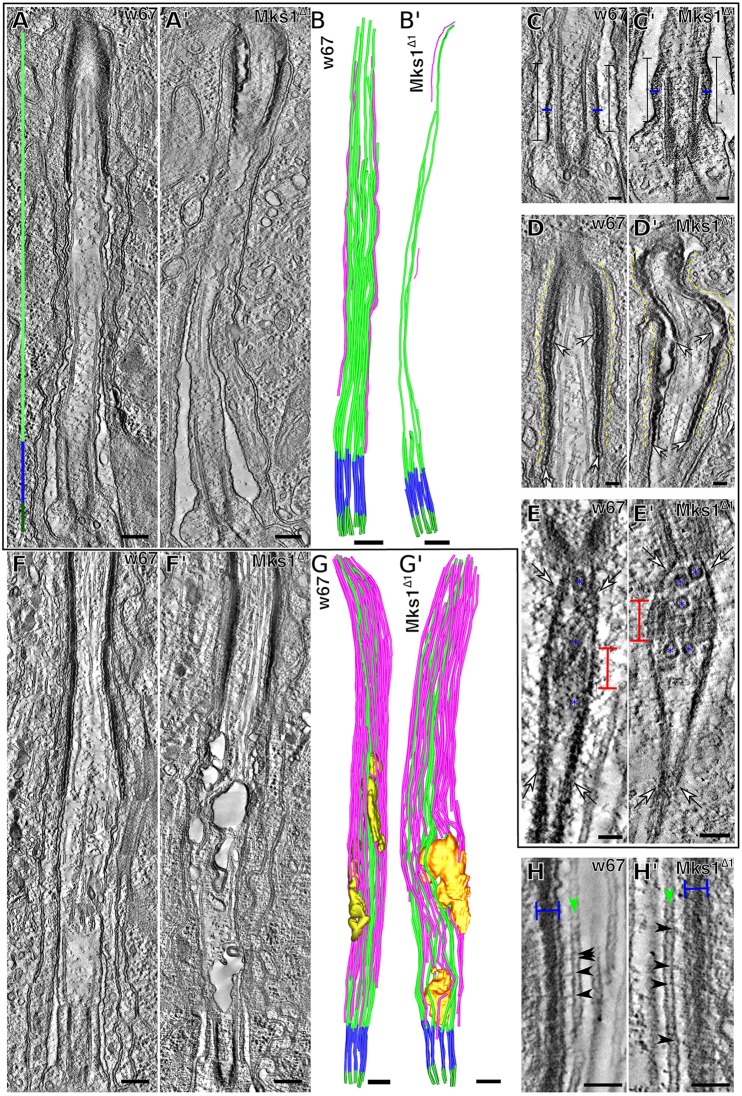
Mks1Δ1 mutant sensory cilia exhibit structural defects at 48 h APF, but are relatively normal by 72 h APF. (A,A′) Micrographs show electron tomograms of the sensory cilium at 48 h APF in WT (A) and Mks1Δ1 mutants (A′). (B,B′) Illustrations show the corresponding 3D models of A,A′, highlighting the BB MTs (dark green), the TZ MTs (blue) and axonemal MTs (light green). Axoneme MTs not directly attached to the BB are highlighted in magenta. (C,C′) Higher magnification electron tomograms of the TZ (square capped lines) in WT (C) and Mks1Δ1 mutants (C′); the TZ is shorter in the mutant, and the electron-dense TZ membrane (blue lines) seems wider and more diffuse. (D,D′) At the tip of the WT axoneme there is a crystalline-like electron-dense structure (D, arrows) located between the ciliary membrane (adjacent to upper arrows) and the sheath cell membrane (highlighted by dotted yellow lines); this structure is present in the Mks1Δ1 mutant cilia (D′) (lower arrows) but the region is less-well organised, and there are gaps between the ciliary and sheath cell membranes (upper arrows). (E,E′) Electron tomograms of the area just below the ciliary BB in WT (E) and Mks1Δ1 mutants (E′) reveal the rootletin filaments (arrows) that originated from the BB, surround the daughter centriole (red capped lines) and extend into the neuronal cell body. Several vesicles (blue asterisks) are visible at the base of the BB and the daughter centriole in the space delimited by the rootlet. Analysis of this area revealed no obvious differences between WT and Mks1Δ1 mutants. (F–G′) Electron tomograms (F,F′) and the corresponding 3D models (G,G′) of WT (F,G) and Mks1Δ1 (F′,G′) sensory cilia at 72 h APF. The number of axonemal MTs increased from 48 h to 72 h, and mutant cilia appear more similar to WT, although an internal membranous structure can be discerned (gold) that is more extensive in Mks1Δ1 mutant cilia. (H,H′) At 72 h APF, electron-dense bridges (black arrowheads) connecting the MTs (green arrowheads) and the ciliary inner membrane are visible in both WT (H) and Mks1∆1 mutants (H′) towards the cilium tip where the electron-dense crystalline-like structure is present (blue capped line) and appears to be organised in a similar way in both WT and Mks1Δ1 mutants. Scale bars: 500 nm in A, A′,B, B′,F,F′,G,G′; 100 nm in all other images.